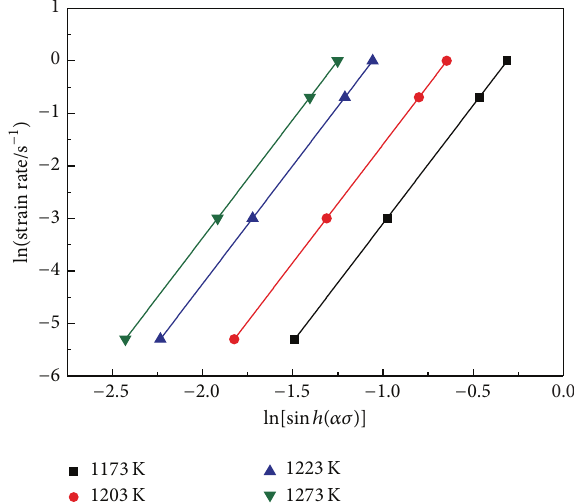
Figure 3: The relationships between ln ̇𝜀 and ln 𝜎 .